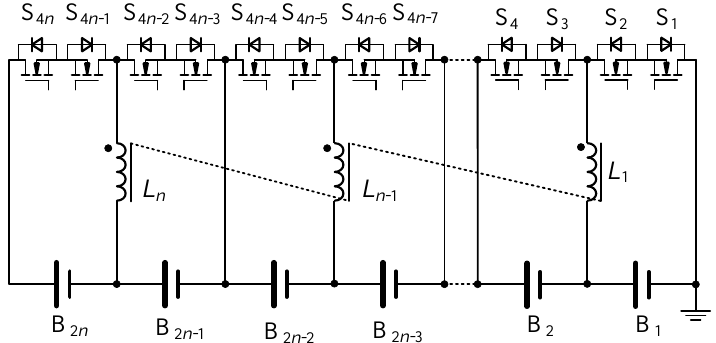
Figure 2. Single-magnetic cell-to-cell charge equalization converter with reduced number of transformer windings [17].